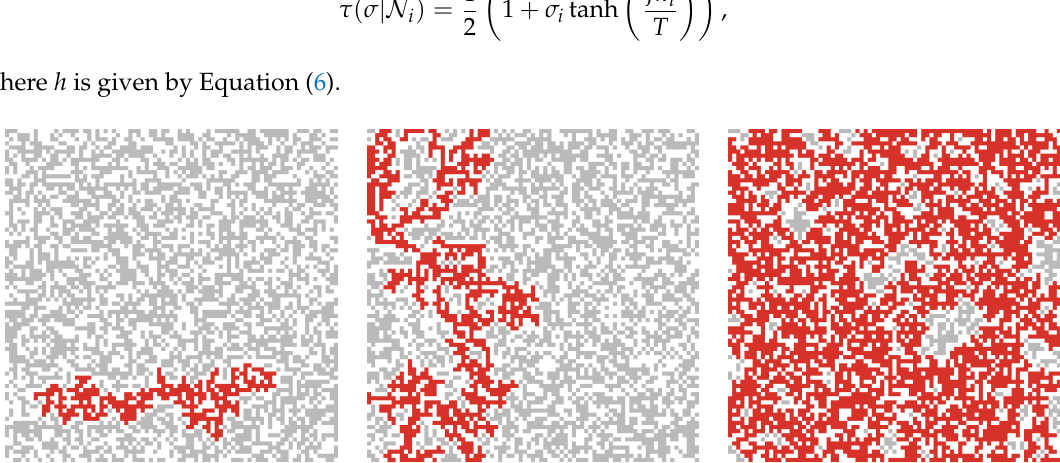
Figure 1. Typical patterns of the percolation model, where the largest component is marked in red: